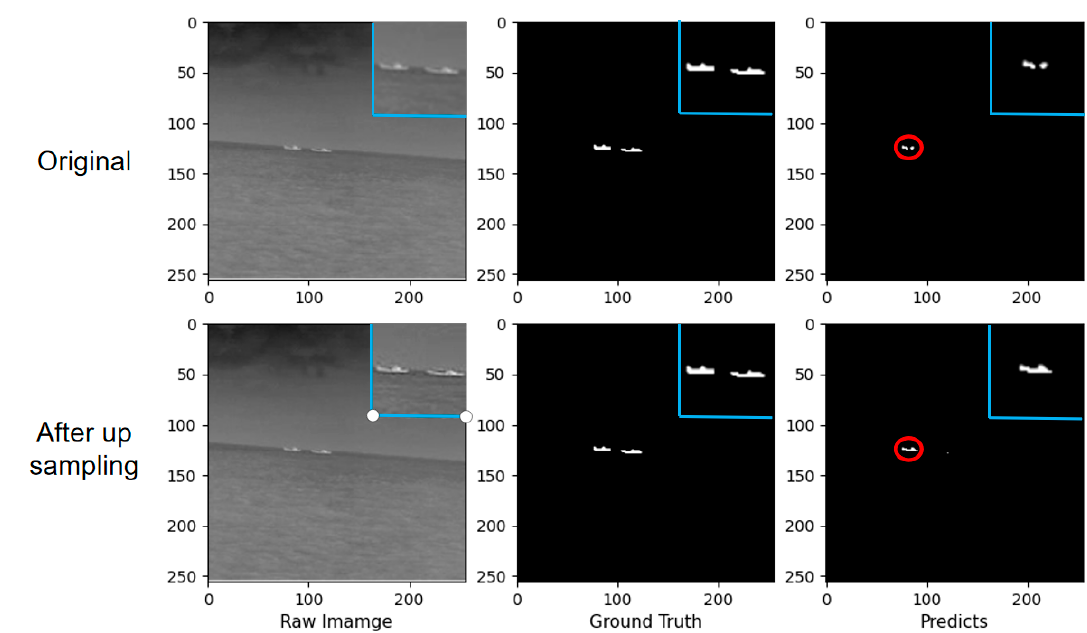
Figure 12. Experiment with expanded target pixels.